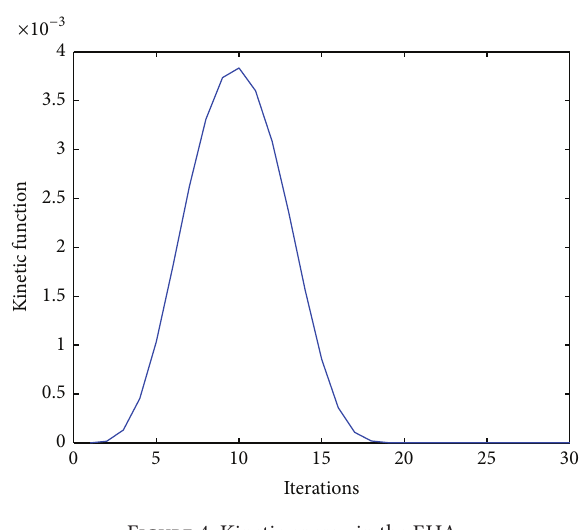
Figure 4: Kinetic energy in the